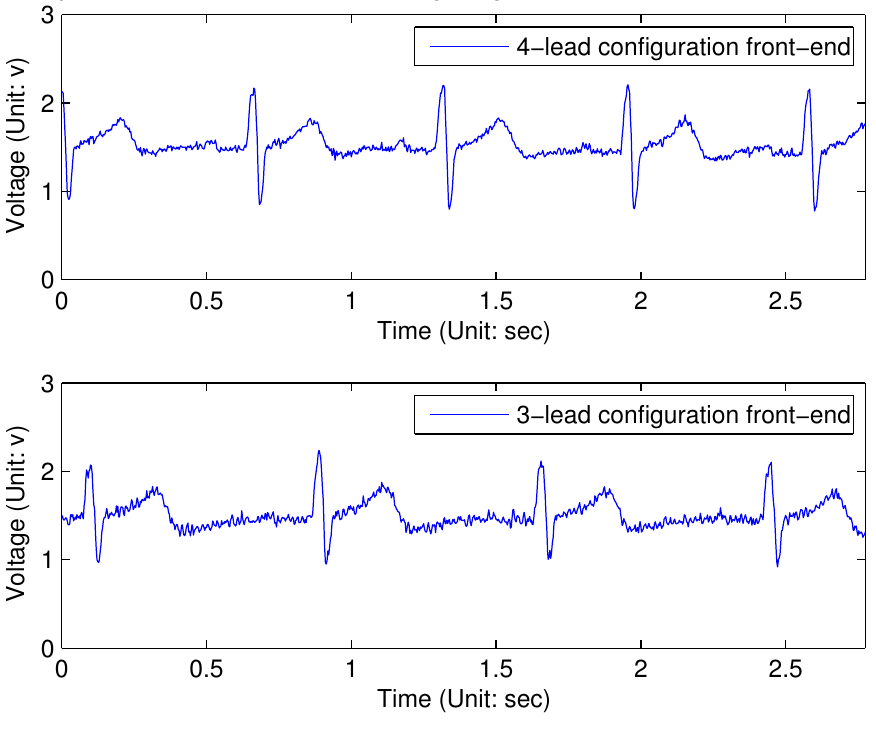
Figure 7. ECG waveforms using different driven right leg circuits in the noise-free environment. The charts show a three-second snapshot.